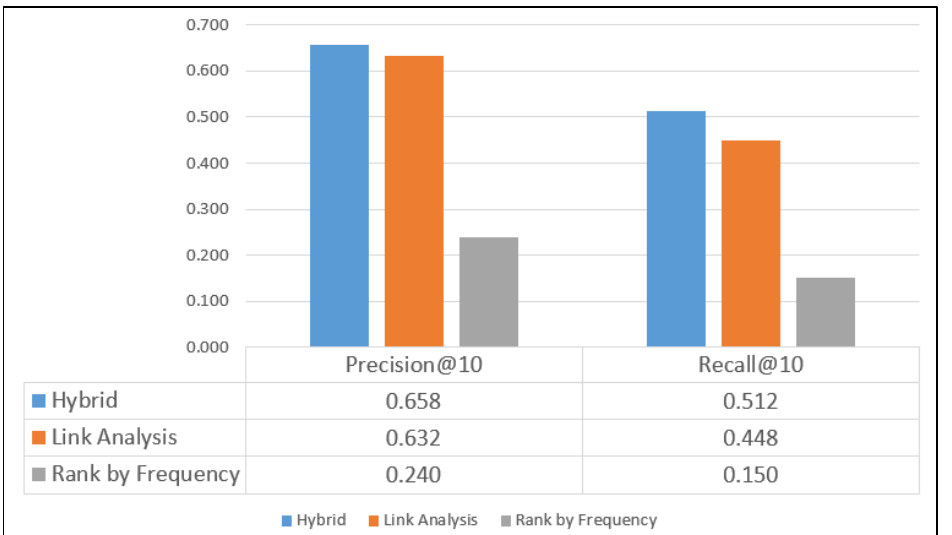
Figure 10. Results for the Weeplaces dataset.